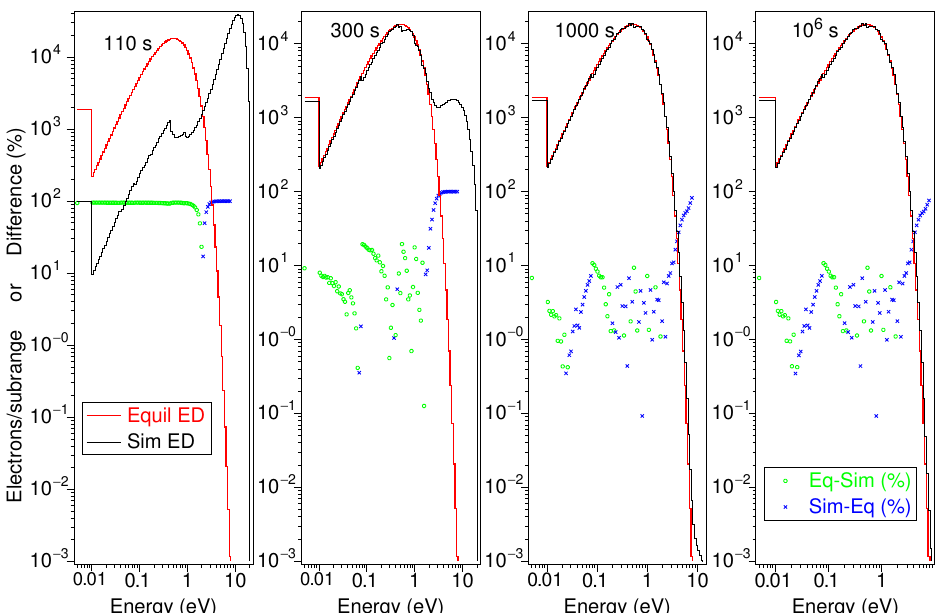
Figure 8. Simulated electron distributions (at 110 s, 300 s, 1000 s and 10 6 s) are plotted along with the predicted equilibrium distribution (thick lines). Errors, being the difference between simulated and theoretical values as a percentage of the larger value, are shown by crosses where the simulated value is larger and circles where it is smaller.